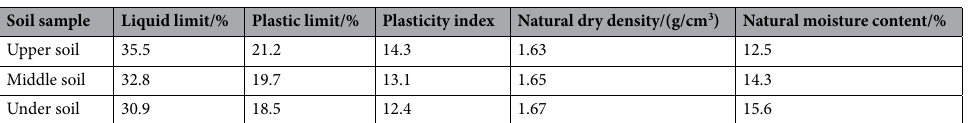
Table 1. Basic properties of soil samples from Zhouqiao